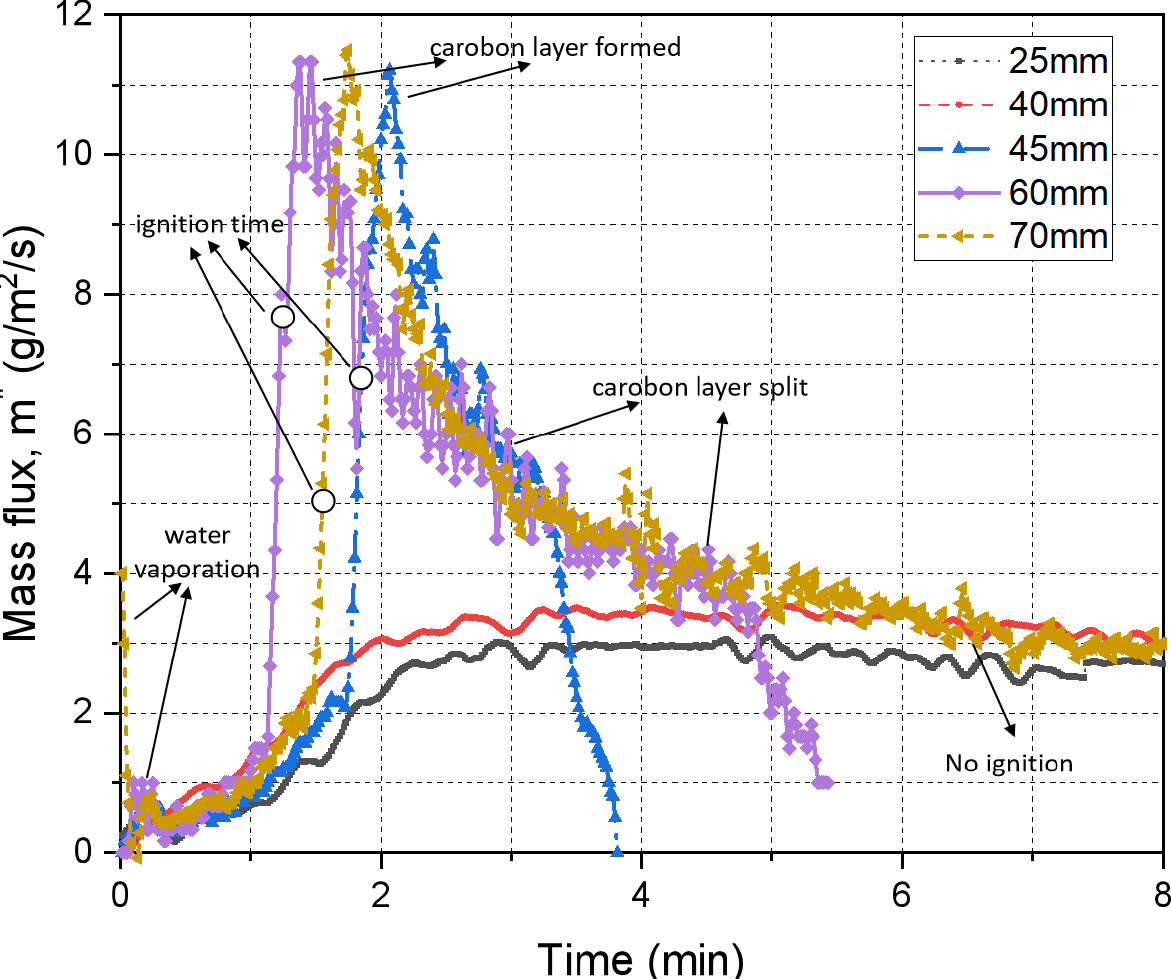
Figure 7. Time evolution of mass flux difference in the ignition process of pine wood with different distances, D.